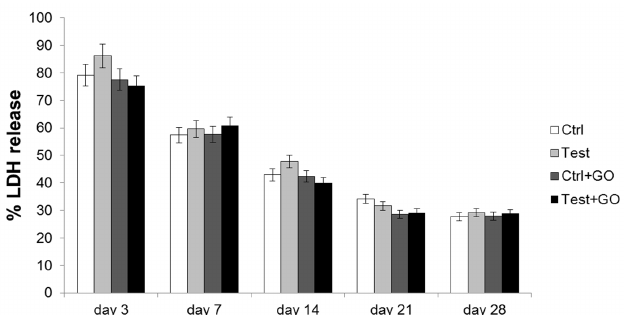
Figure 7. LDH assay of DPSCs cultured on control, test, control + GO, and test + GO discs for 3, 7, 14, 21, and 28 days. LDH released is reported as percentage. Data shown are the mean (± SD) of three separate experiments.